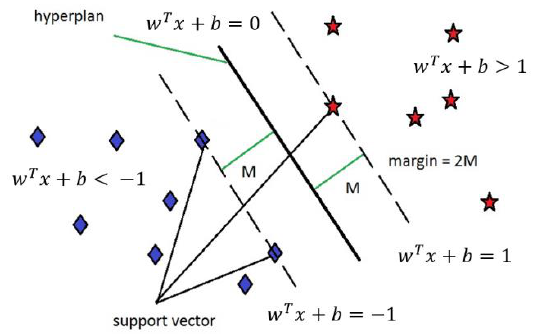
Figure 1. The support vector machine (SVM) with the linear separable case.